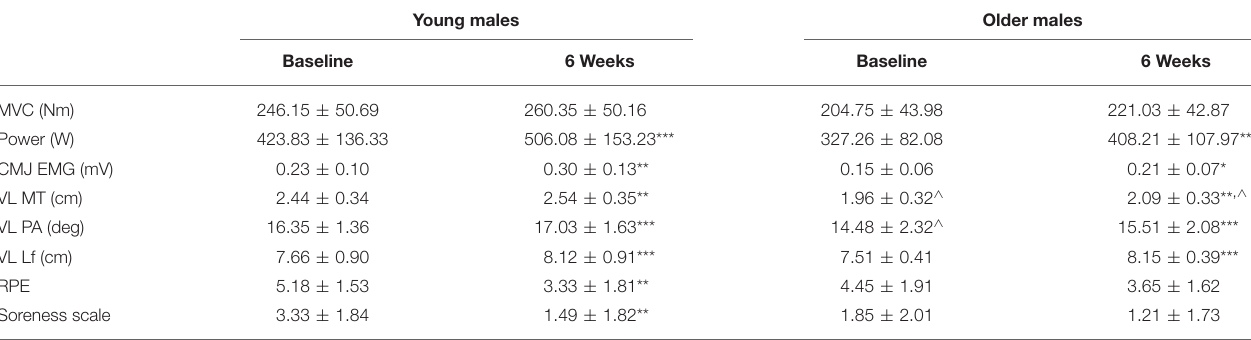
TABLE 1 | Pre-to-post values for muscle functional and morphological features.